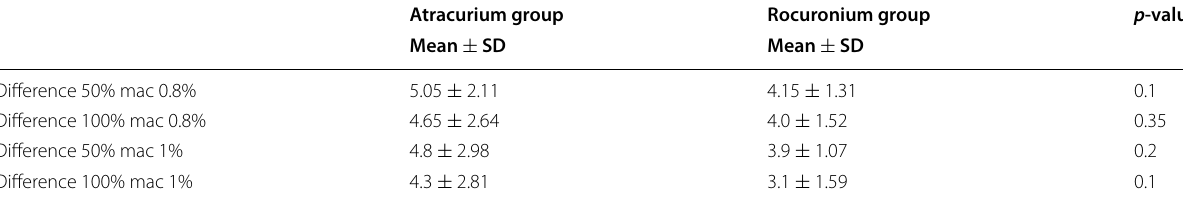
Table 2 RE-SE difference at different MAC and TOF